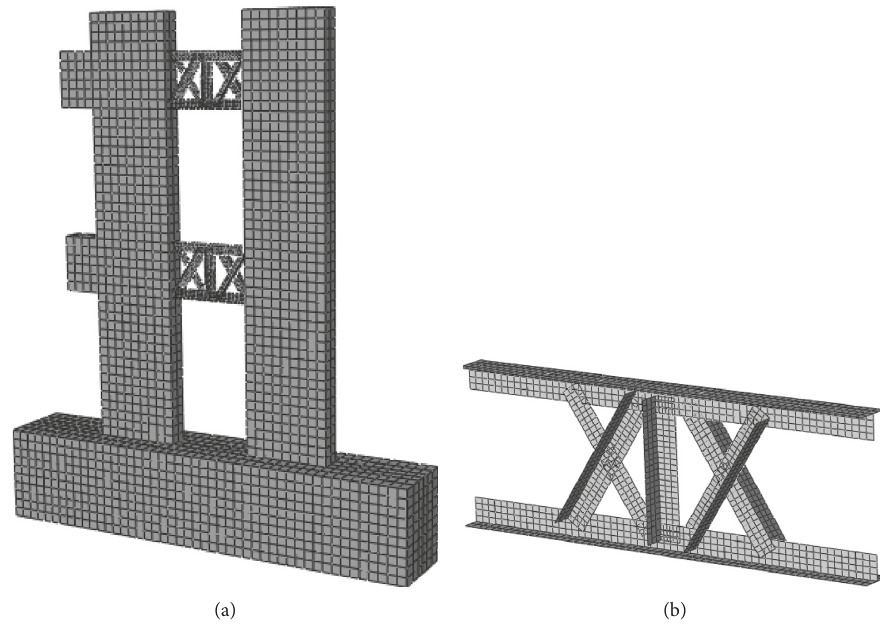
Figure 3: The finite element model: (a) shear wall structure; (b)